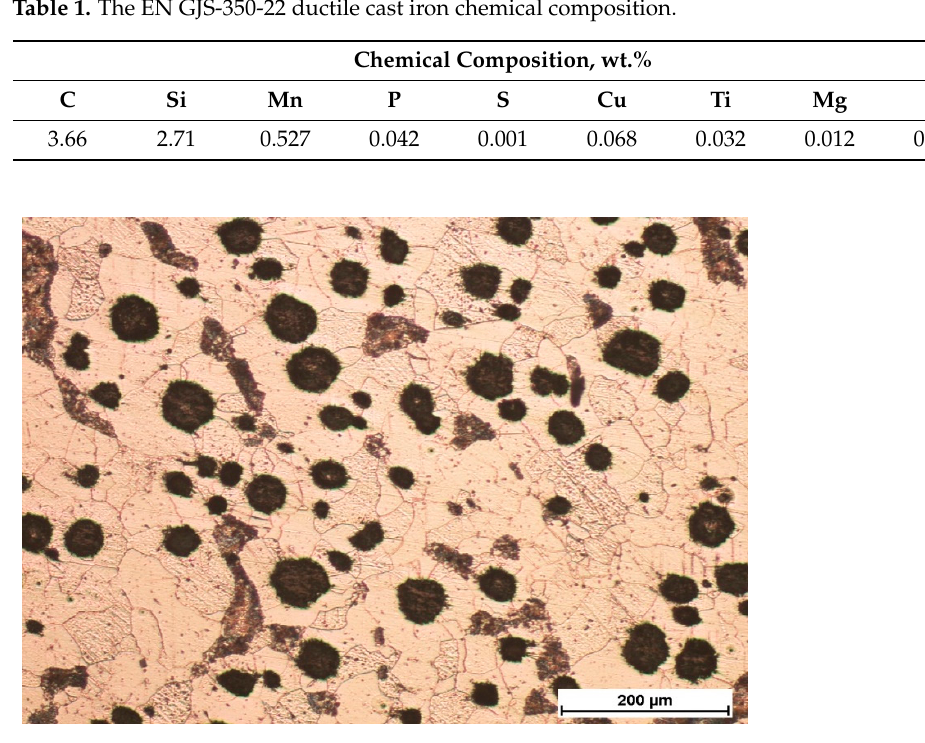
Figure 1. The ductile cast iron EN GJS-350-22 microstructure (optical microscope).